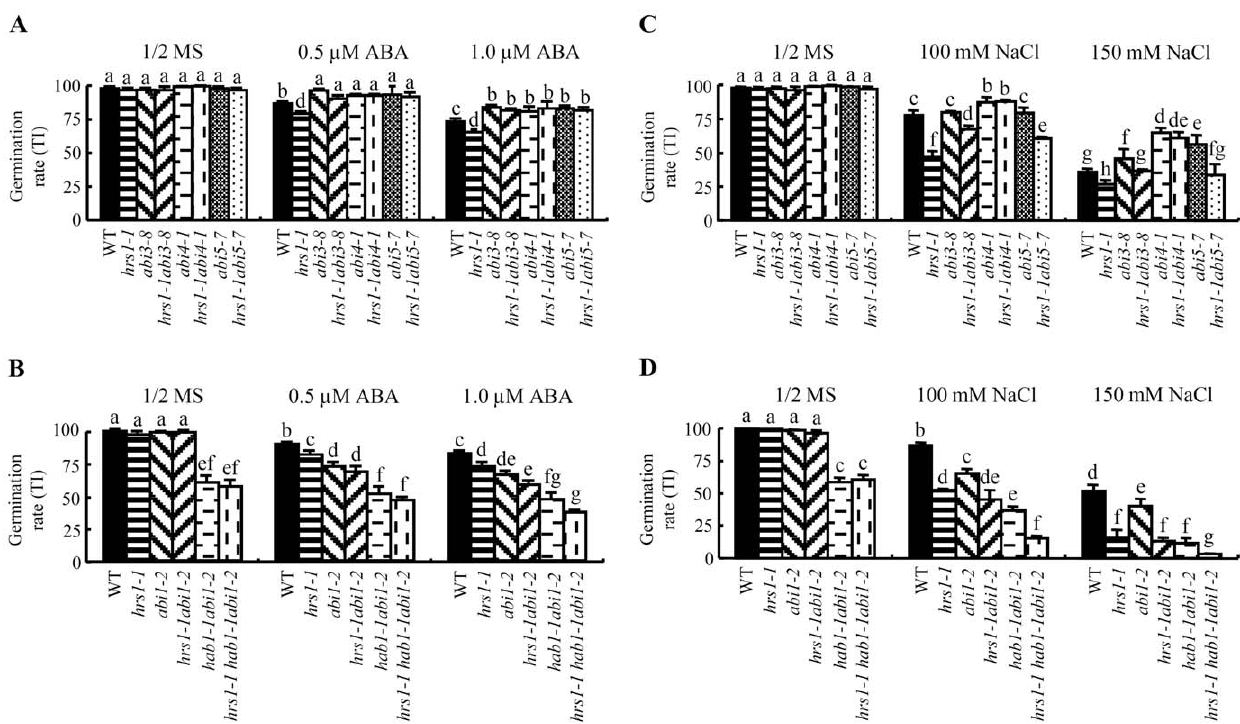
Figure 3. Genetic analysis of hrs1-1 germination. Germination rate (TI, mean 6 SD, each calculated using the measurements from triplicate samples) was used to compare the germination behavior of different genotypes. The datasets presented are each representative of at least three independent experiments. Based on multiple statistical comparisons, the means labeled by one or more identical letters do not differ significantly from each other ( P # 0.05). (A) Comparisons of the germination rates of WT control, four single mutants ( hrs1-1 , abi3-8 , abi4-1 and abi5-7 ), and three double mutants ( hrs1-1abi3-8 , hrs1-1abi4-1 and hrs1-1abi5-7 ) on 1/2 MS medium or those with two different concentrations of ABA. (B) Comparisons of the germination rates of WT control, two single mutants ( hrs1-1 and abi1-2 ), two double mutants ( hrs1-1abi1-2 and hab1-1abi1-2 ), and one triple mutant ( hrs1-1hab1-1abi1-2 ) on 1/2 MS medium or those with two different concentrations of ABA. (C) The germination rates of WT control, four single mutants ( hrs1-1 , abi3-8 , abi4-1 and abi5-7 ), and three double mutants ( hrs1-1abi3-8 , hrs1-1abi4-1 and hrs1-1abi5-7 ) on 1/2 MS medium or those containing two concentrations of NaCl. (D) The germination rates of WT control, two single mutants ( hrs1-1 and abi1-2 ), two double mutants ( hrs1- 1abi1-2 and hab1-1abi1-2 ), and one triple mutant ( hrs1-1hab1-1abi1-2 ) on 1/2 MS medium or those supplemented with two concentrations of NaCl.